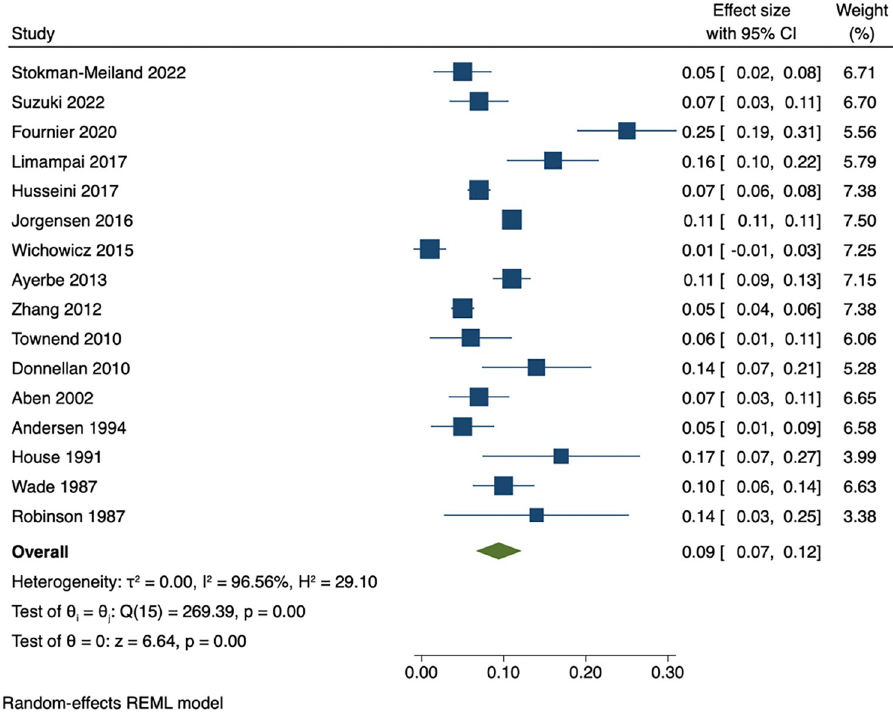
Fig 5. Proportion of incident cases of depression between 3 months and 1 year after stroke.